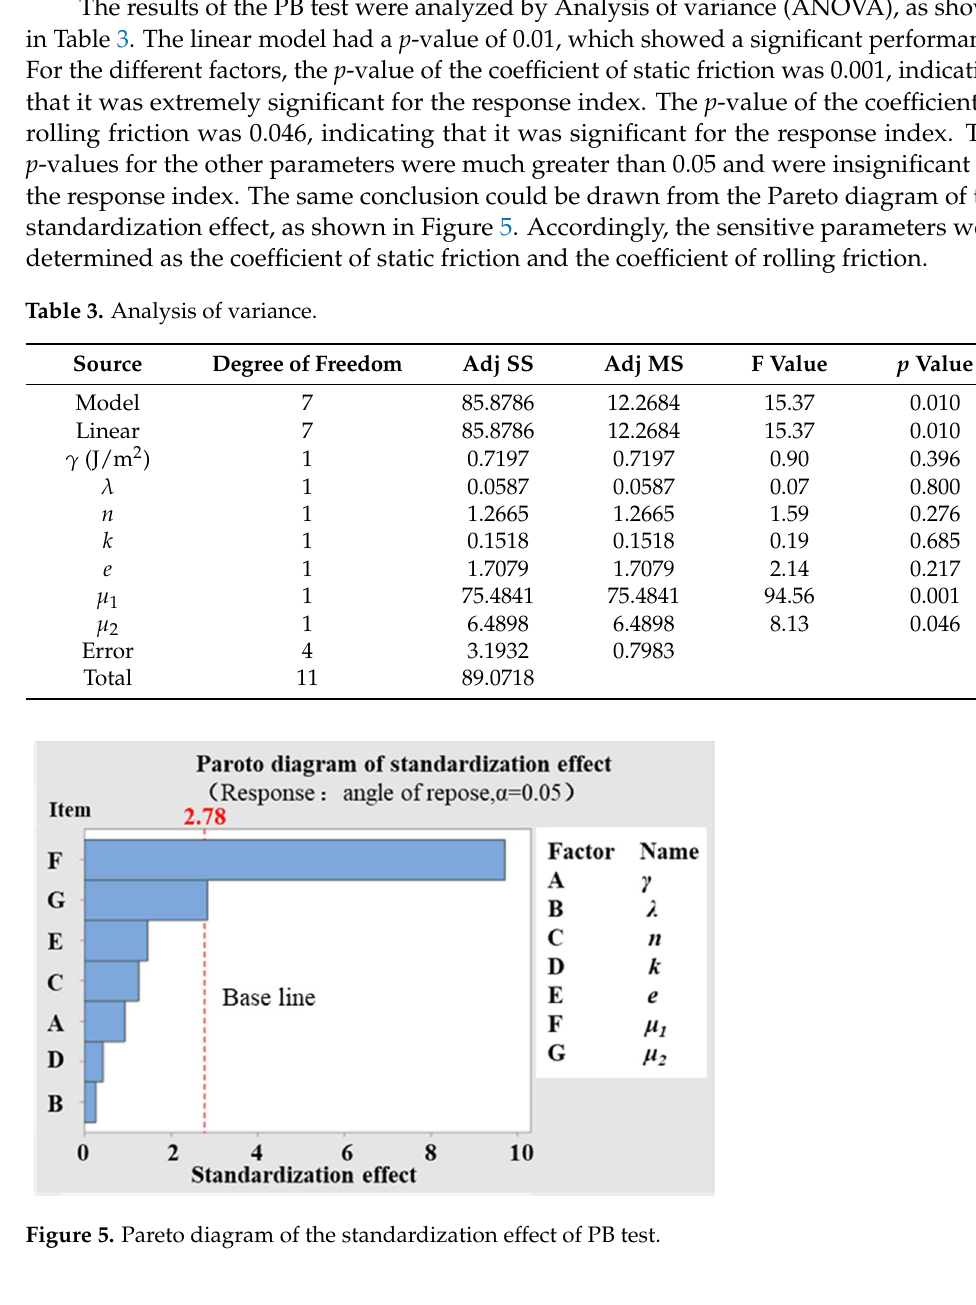
Table 4. CCD test and simulation results of three varieties.